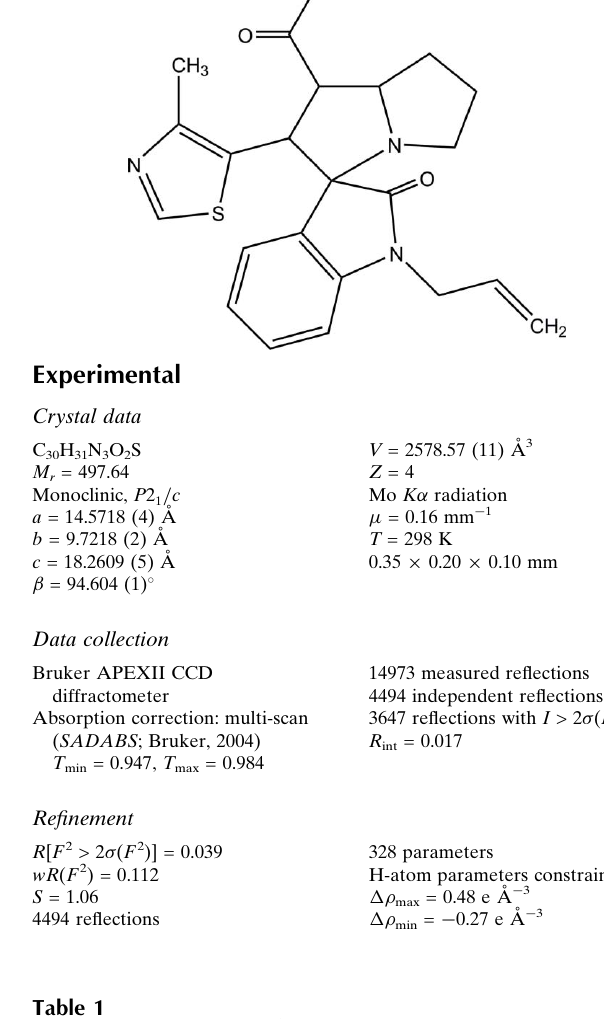
Hydrogen-bond geometry (A˚ , (cid:2)